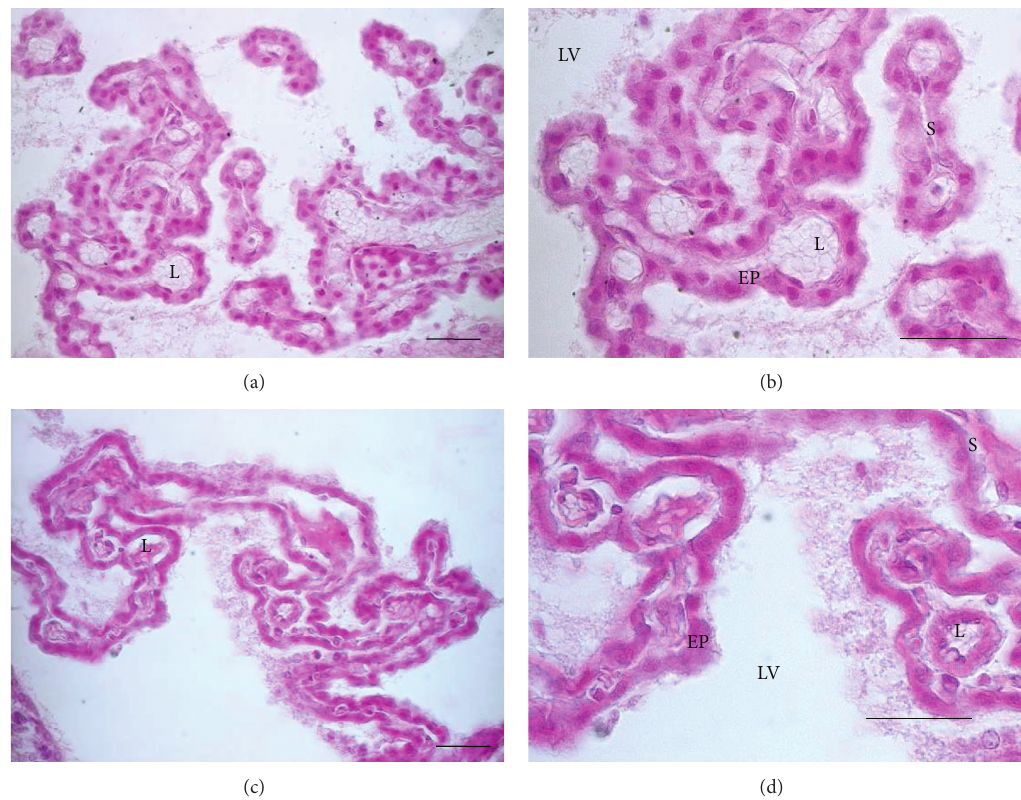
F 1: Coronal sections of rats showing choroid plexus of the lateral ventricle stained with hematoxylin-eosin: WKY rats, ((a) and (b)) and SHR ((c) and (d)). Abbreviations: L: lumen, EP: epithelium of the choroid plexus, S: stroma, and LV: lateral ventricle (bars = 30